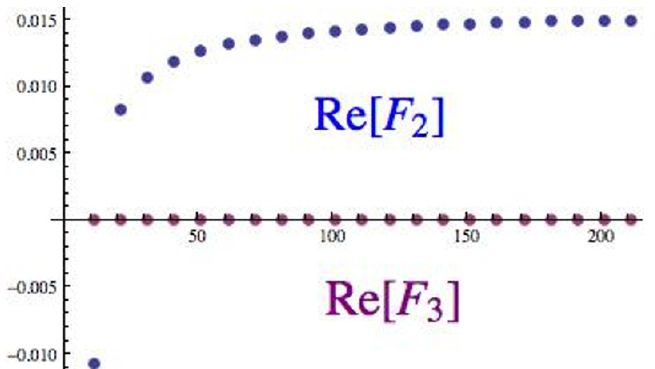
Figure 1 . The N roots of P N ( z ) for (cid:17) = e iv = 1 on S 1 .